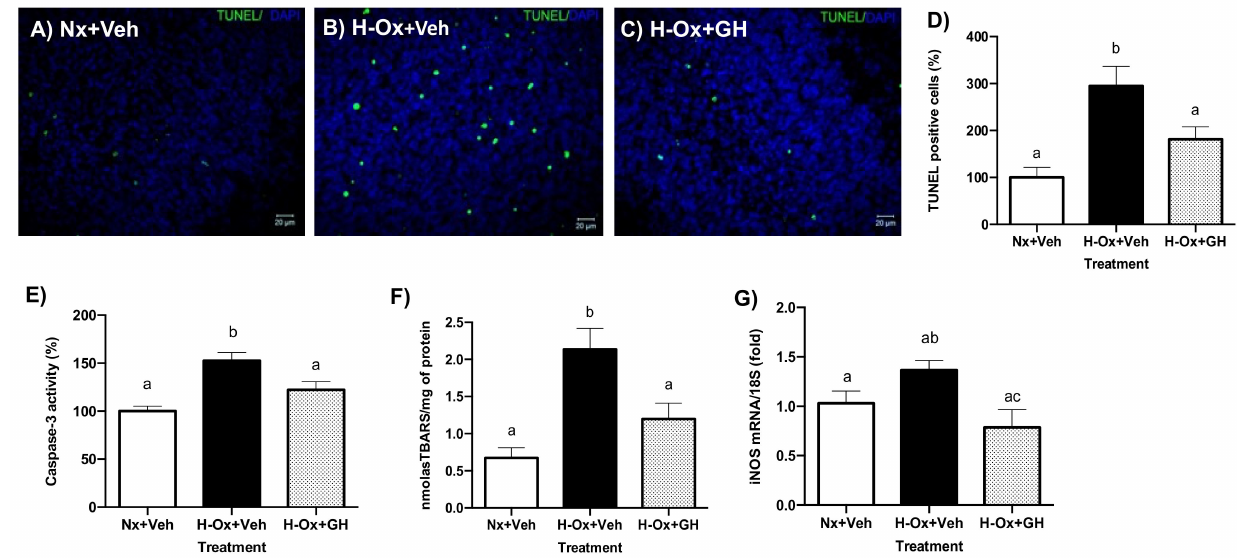
Figure 6. Protective effects of GH treatment on apoptosis and oxidative stress induced by hypoxia injury in embryonic cerebellum. ( A – C ) Representative images showing the number of apoptotic cells by TUNEL under normoxia (Nx,) ( A ), hypoxia (H-Ox), ( B ), and GH treatment (H-Ox+GH), ( C ). ( D ) Proportion of TUNEL area fractions expressed in percentage (%), in the different conditions. ( E ) Caspase-3 activity assay in percentage (%). ( F ) Lipid peroxidation assay. ( G ) Expression of iNOS mRNA by qPCR. Bars represent the mean ± SEM, n = 4 independent experiments by duplicate. Groups with different letters are significantly different by one-way ANOVA and Tukey’s post hoc test. Scale bar 20 µ